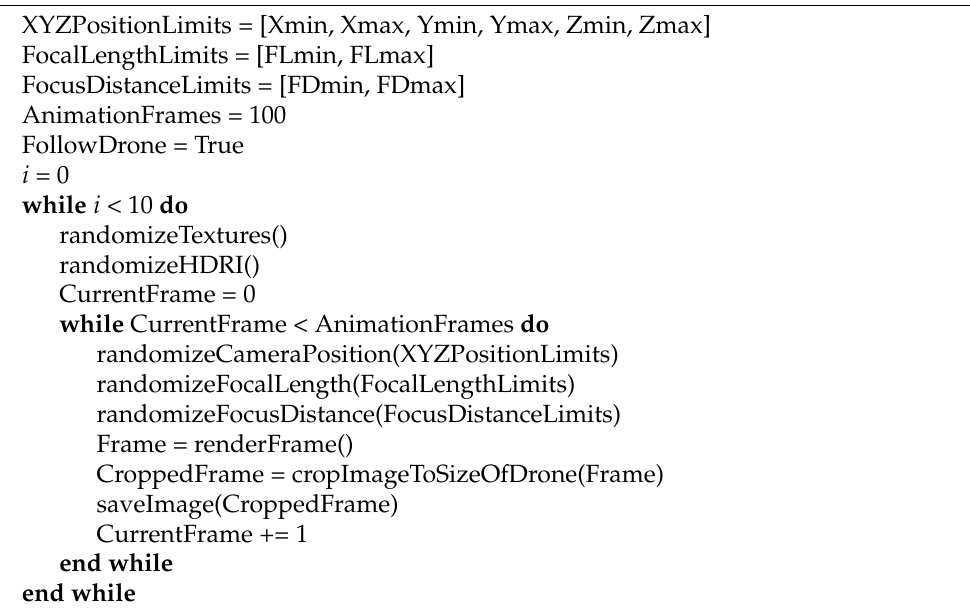
Algorithm 1 Synthetic drone rendering